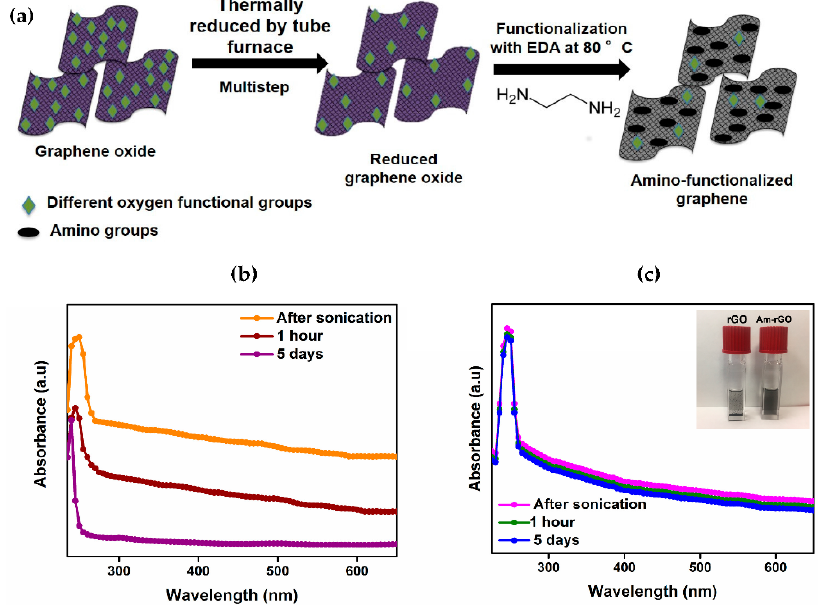
Figure 2. ( a ) Schematic illustration of the non-covalent functionalization of graphene surfaces with amino groups. Time evolution of UV-Vis absorption spectra of ( b ) rGO and ( c ) Am-rGO dispersed in CHCl 3 /DMF (inset shows photograph of GO, rGO and Am-rGO).